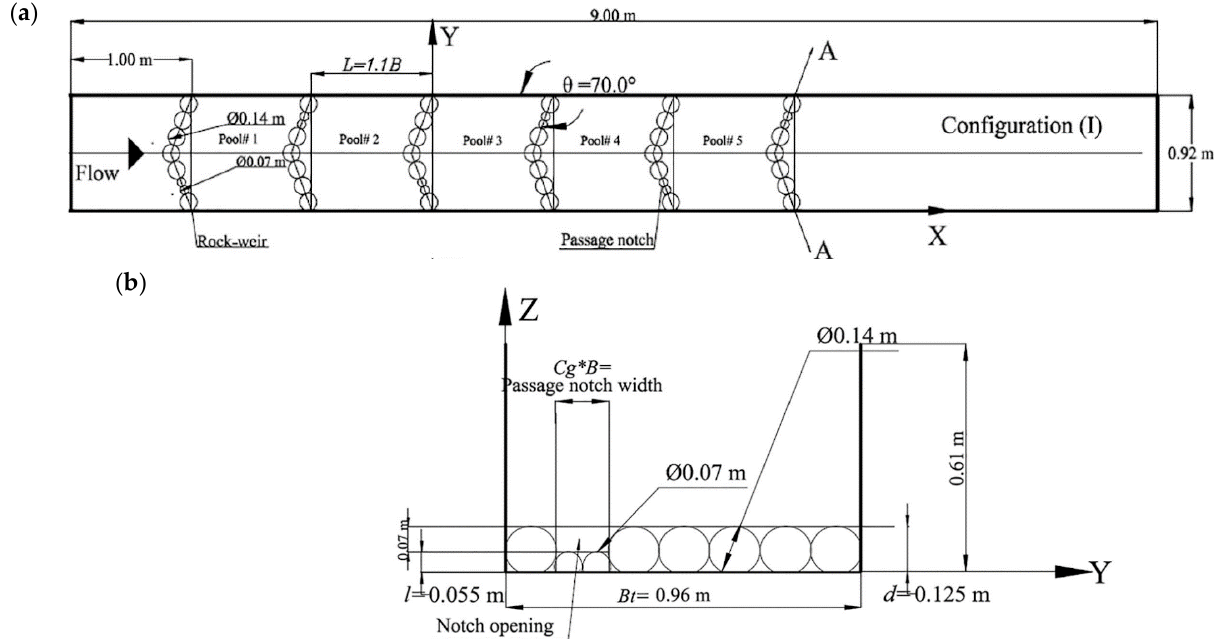
Figure 7. The model domain. ( a ) Plan view and ( b ) sectional A-A view—both taken from [16].